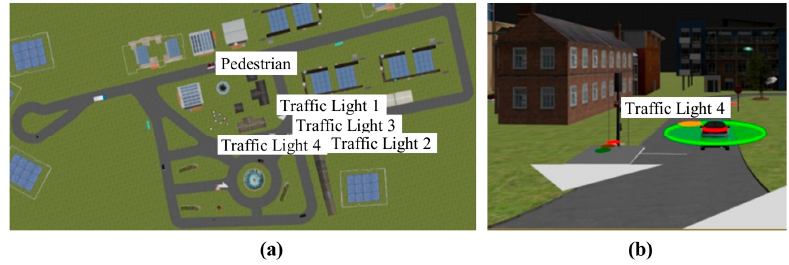
Figure 5. ( a ) Aerial view of simulation scenario of the CPS. ( b ) A fully automated vehicle model.